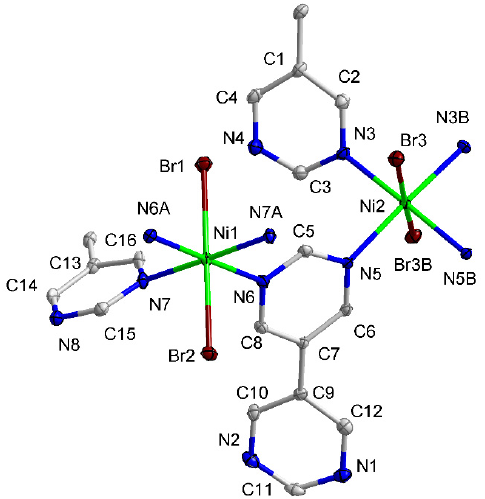
Figure 1. The perspective view of the local coordination environment of Ni(II) center and bpym ligand for the structure of the compound 1 . The H atoms of bpym ligand are been omitted for clarity. (symmetry codes, A: 2-x, y, 0.5-z; B: 2-x, y, 1.5-z).